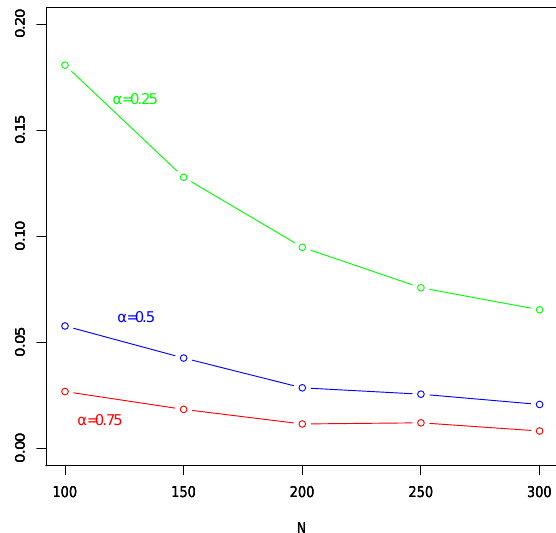
Figure 4. Approximate entropy (ApEn) of FIBM, for various value of α (specified by labels inside the figure) and N (on the horizontal axes).